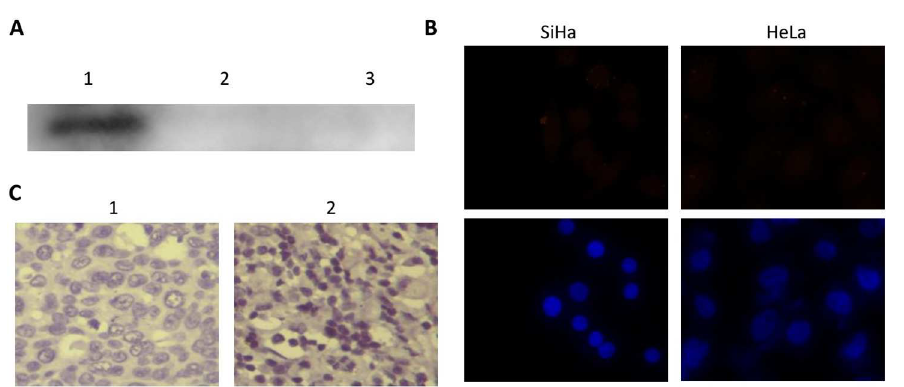
Fig 4. Examination of the cross-reaction of HPV 58 E7 antibody. (A) western blotting for the detection of HPV58 E7. Lanes 1, 2 and 3 are the pure protein of HPV 58, 16 and 18 E7. (B) Immunofluorescentanalysis for the detectionof HPV58 E7 in SiHa and HeLa cells. (C) Immunohistochemistry stain for the detectionof HPV58 E7 in cervical cancer cells, which was HPV 16- or 18-positive, HPV 58 was negative.1 is the HPV16-positive sample and 2 is the HPV18-positive sample.